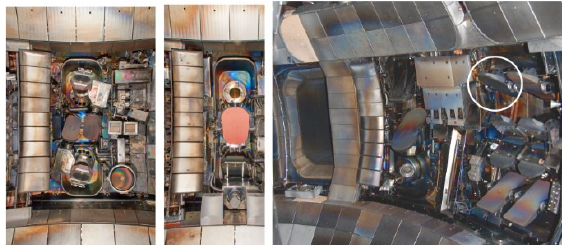
Fig. 1. Schematic top view on the plasma midplane cross section of ASDEX Upgrade, two-pass ECRH heating beams are shown in colour. The vacuum vessel consists of 16 segments. ECRH launchers are located in segments 5,6,8 and 14. Since the four launchers in segment 5 would shadow each other in this view, only two of them are shown for simplicity. The beam trajectories in segment 5 do not start or end in the midplane, they have a significant vertical component and appear shortened in the projection of this view.